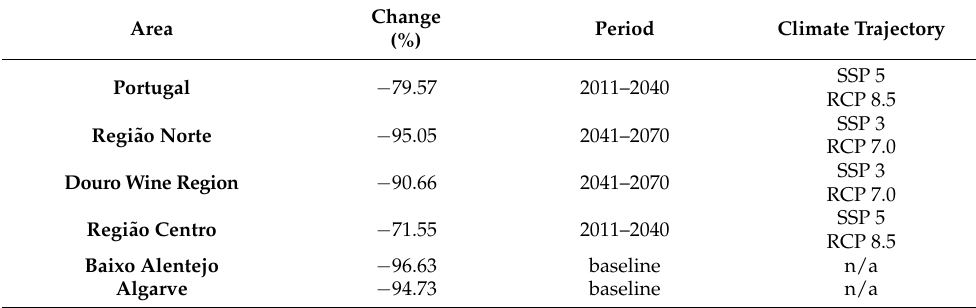
Figure 4. Predictions (EPSG:3035) for the 2041–2070 period; the figure follows the style of Figure 2. ( Left panels ) with irrigation, ( right panels ) without irrigation, ( top panels ) SSP3-7.0 climate trajectory, ( bottom ) SSP5-8.5 climate trajectory. Table 2. Summary of the most extreme climate change scenario effects without irrigation on suitable area relative to the baseline period (1981–2010) across Portugal and the five focal